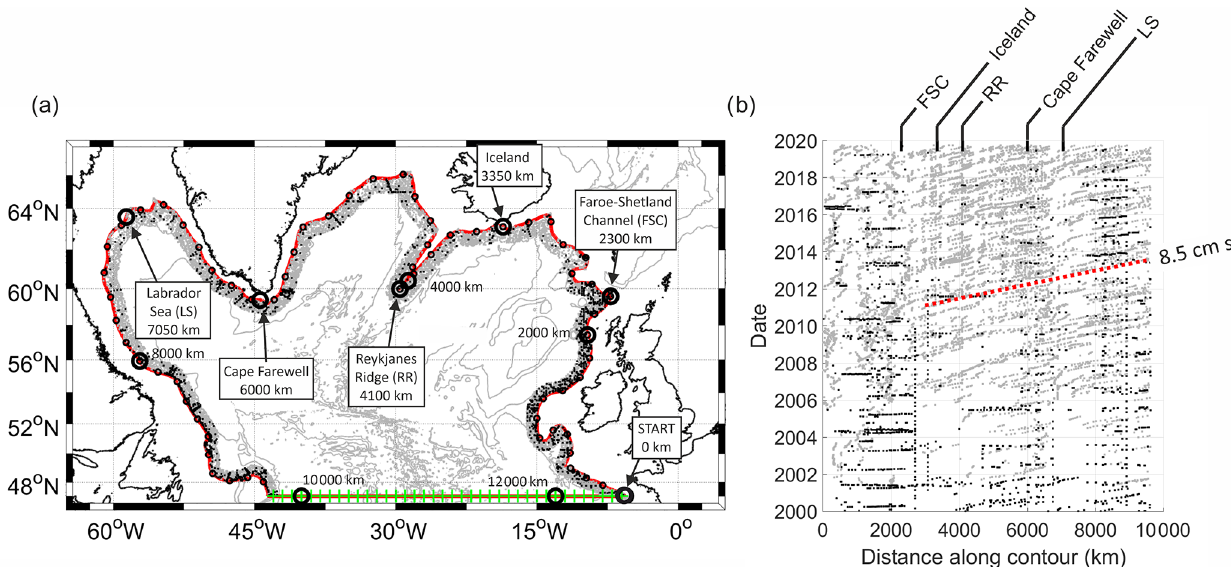
Figure 2. (a) Location of profiles contributing to the basin perimeter data product. Black points show CTD profiles, while grey points show Argo profiles. The 1000m bathymetry contour is shown in red. The profiles extend up to 75km offshore from the 1000m contour. Small black circles on boundary contour show grid locations of boundary data product, while green crosses show grid locations of EN4 zonal section at 47 ◦ N. Bathymetry contours from GEBCO bathymetry (http://www.gebco.net/, last access: 15 June 2020). GEBCO stands for General Bathymetry Chart of the Oceans. (b) Distribution of profiles contributing to the boundary dataset plotted over time. Black points show CTD profiles, while grey points show Argo profiles. The dashed red line shows the average Argo float speed of 8.5cms − 1 around the boundary. Key locations around boundary are labelled as follows: Faroe–Shetland Channel (FSC), the southernmost point of Iceland, Reykjanes Ridge (RR, southern tip), Cape Farewell, and the Labrador Sea